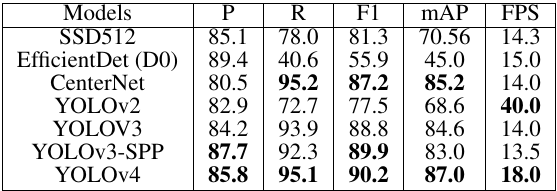
Table 1. Result of detection in custom dataset.